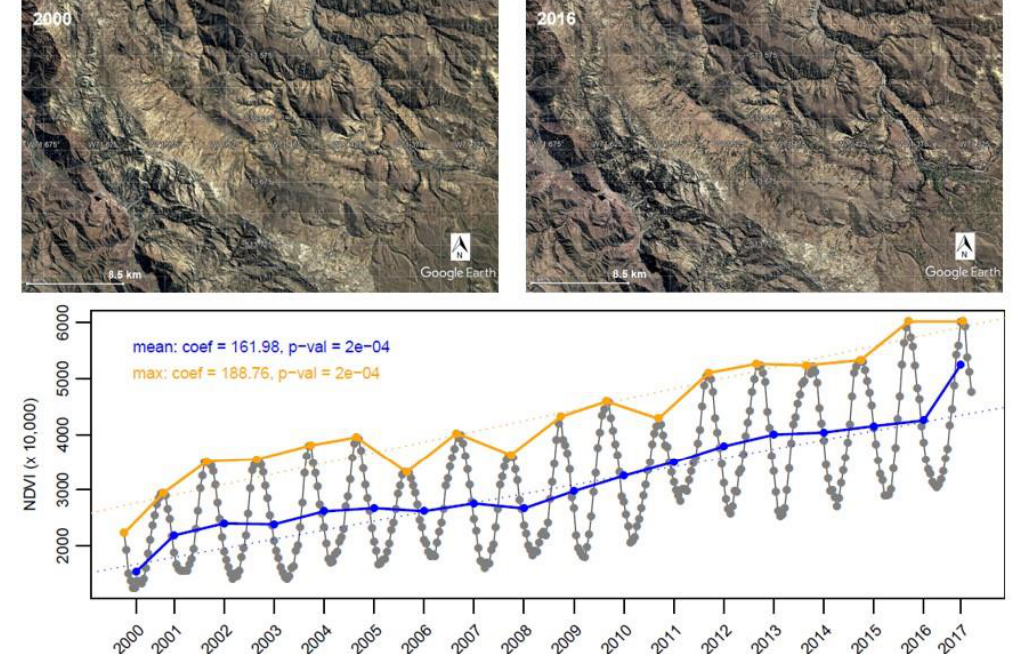
Figure 12. In the upper panels, high spatial resolution imagery from Google Earth Pro shows Andean Highlands greening east of Cusco between 2000 and 2016. Expanding pine and eucalyptus plantations are likely drivers of gradual greening in this region. The accompanying graph shows the entire time-series of the NDVI data and fitted Thiel-Sen trends for NDVI-mean (blue) and NDVI-maximum (orange) for a pixel located at S 13.662586 ◦ , W 71.522592 ◦